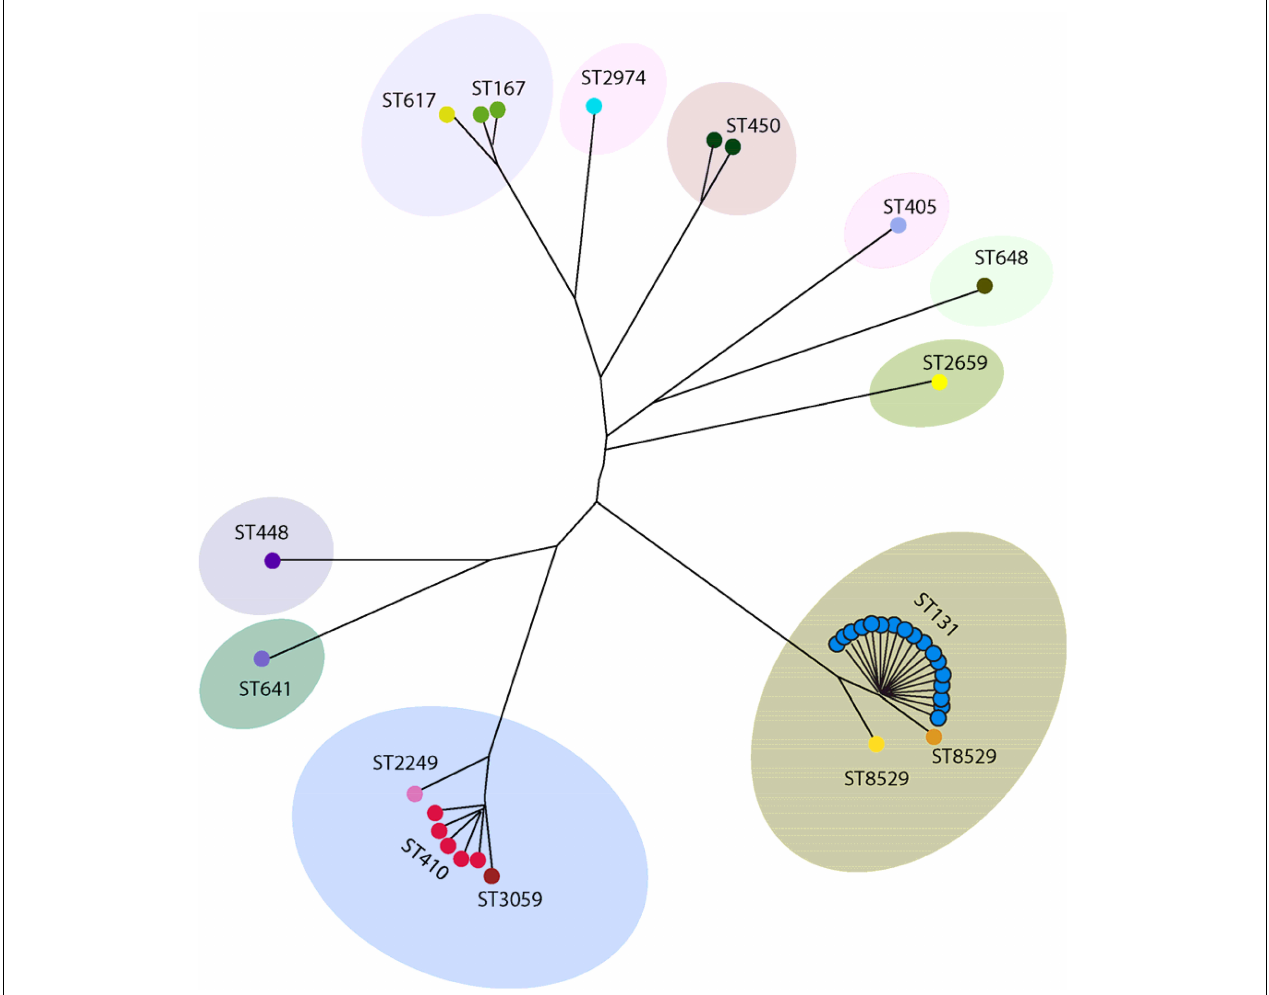
FIGURE 6 | Phylogenetic distribution of 40 ESBL producing E. coli according their sequence types. The phylogenetic construction was done using Phyloviz software based on the seven MLST gene sequences. The sequence type with single locus variants are grouped together and indicated in a single